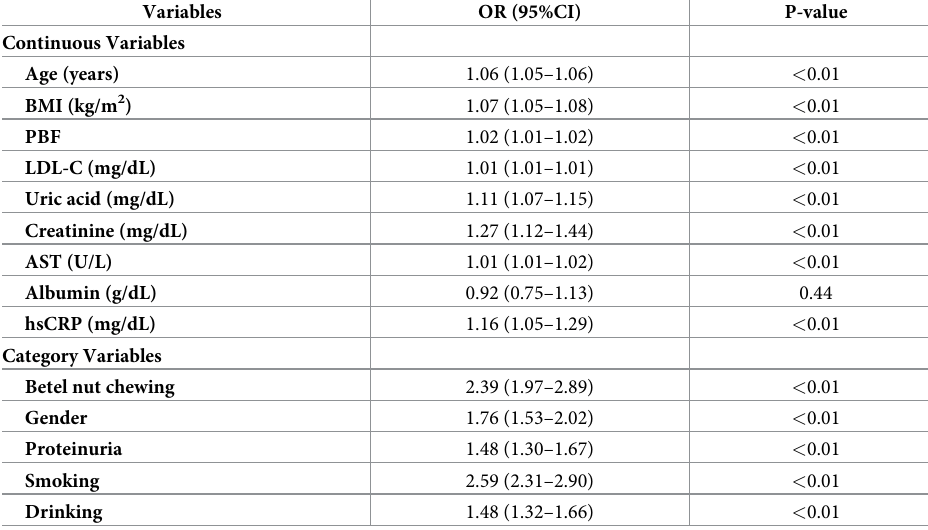
Table 2. Univariate regression analyses for the presence of colorectal polyps.